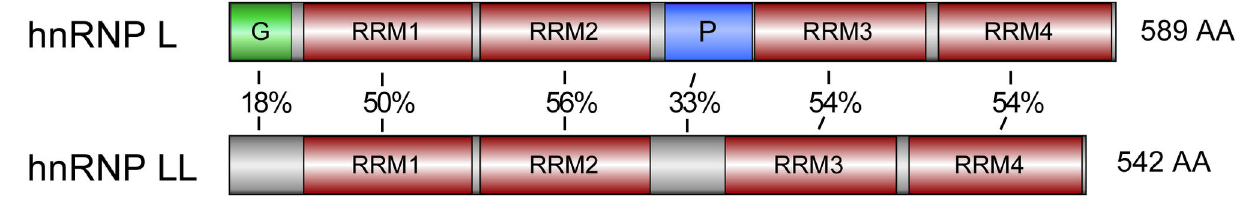
Figure 1. Domain architecture and conservation of hnRNP L and hnRNP LL. Domain structure of hnRNP L (top) or hnRNP LL (bottom) showing total protein size and relative location and size of RNA-recognition motifs (RRMs) and linker regions (grey) including the glycine-rich (G) and proline-rich (P) segments of hnRNP L. Percent amino acid identity for each domain of hnRNP L compared to the respective domain of hnRNP LL is given between protein